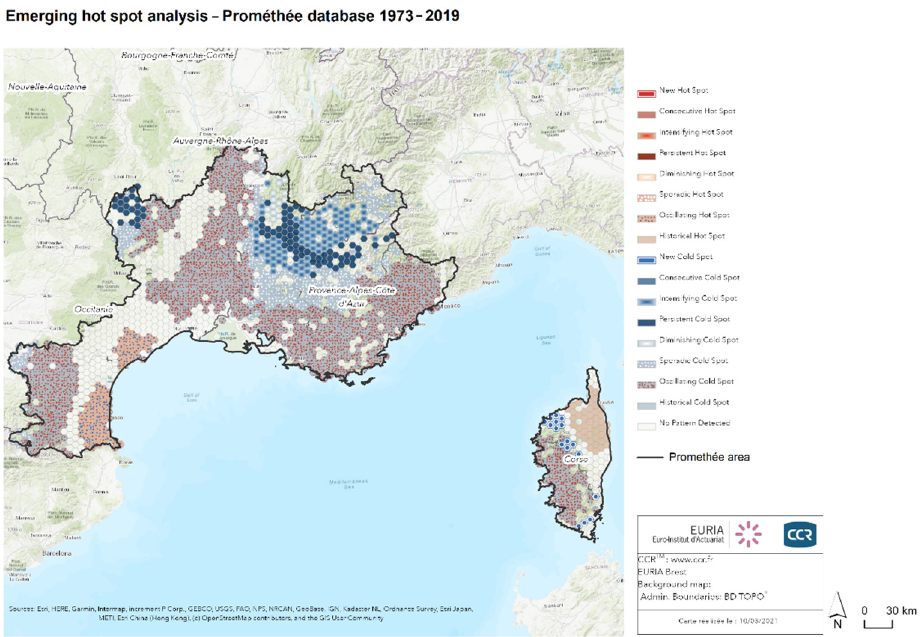
Figure 13. Emerging hot spot analysis for the Promethée dataset